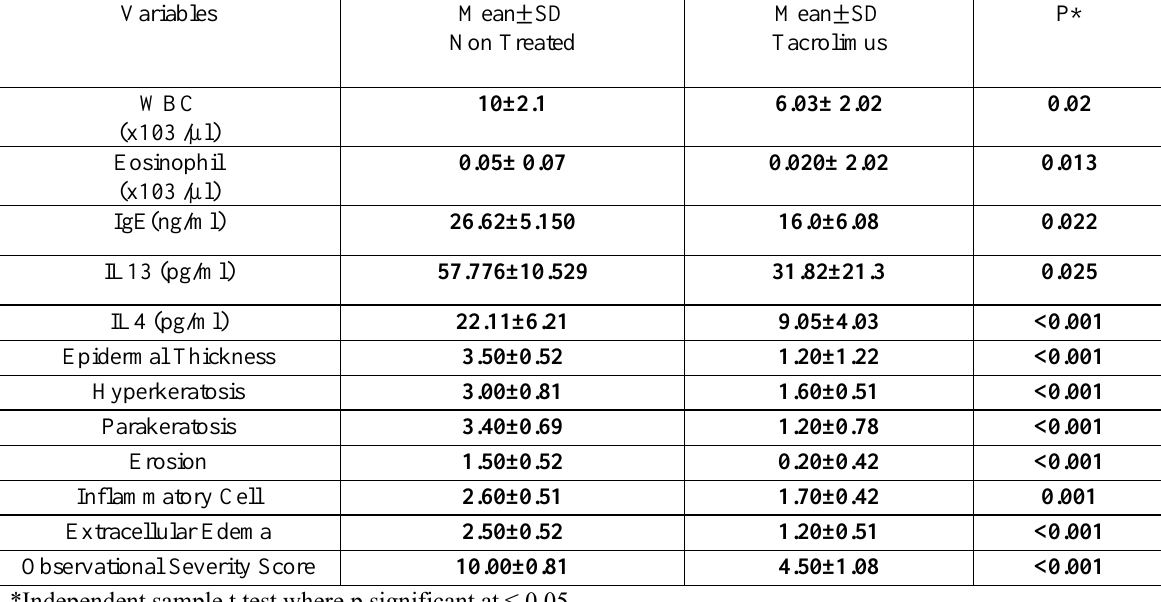
Table 4. Comparisons of non-treated atopic dermatitis induced group with Tacrolimus treated group regarding WBC, Eosinophil, serum IgE, and skin tissue homogenate of IL-4 and IL-13, observational severity score, and histopathological